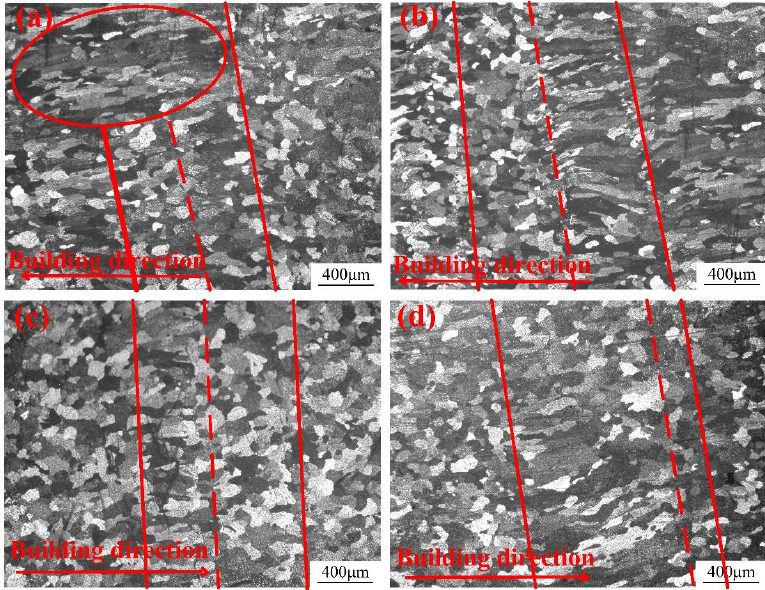
Figure 11. Optical microscope (OM) photographs of samples deposited by the ( a ) NC process, ( b ) interlayer cooling (IC) process, ( c ) OL process, and ( d ) substrate cooling (SC) process.